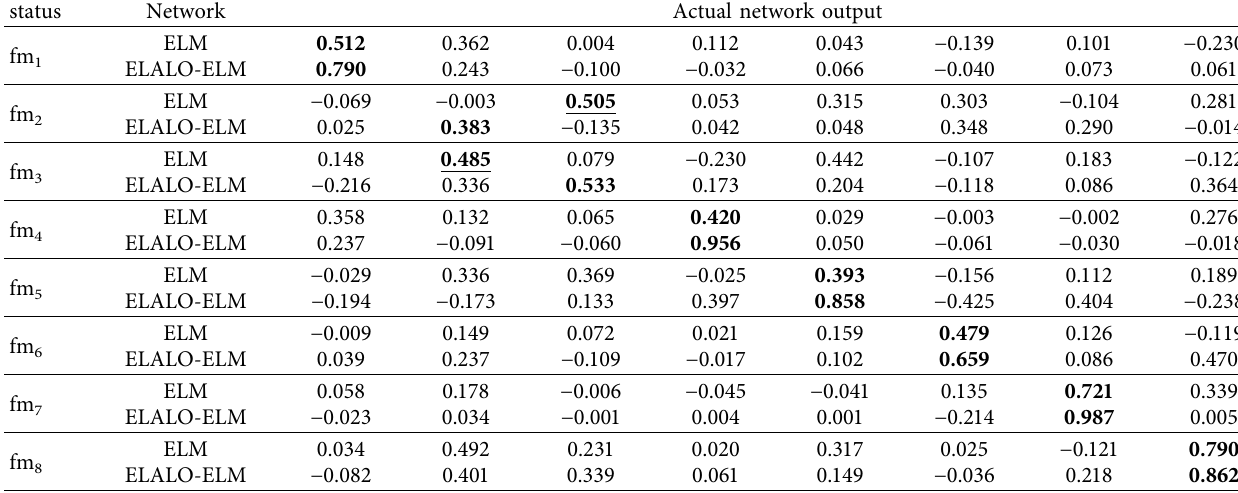
Table 5: Actual output comparison of ELM and ELALO-ELM.